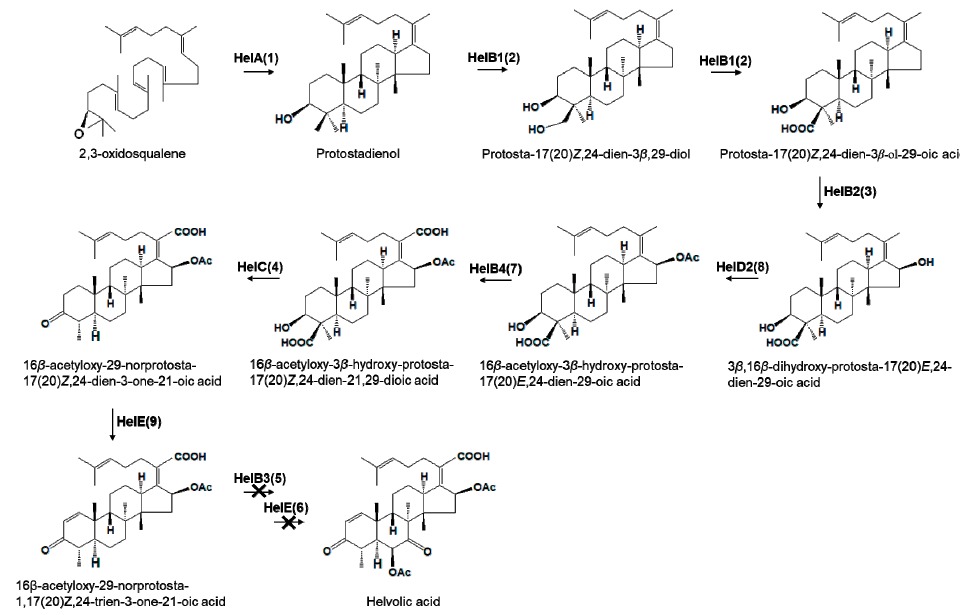
Figure 7. Putative pathways of triterpenoid biosynthesis in C. farinosa .